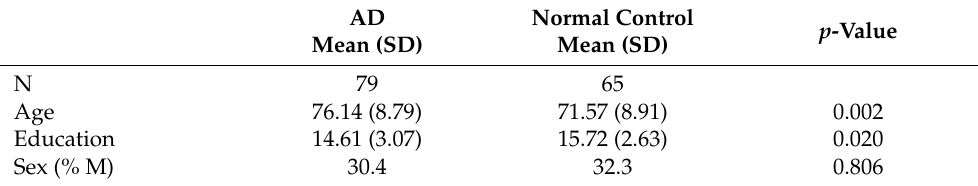
Table 1. Demographic characteristics of the cohort.